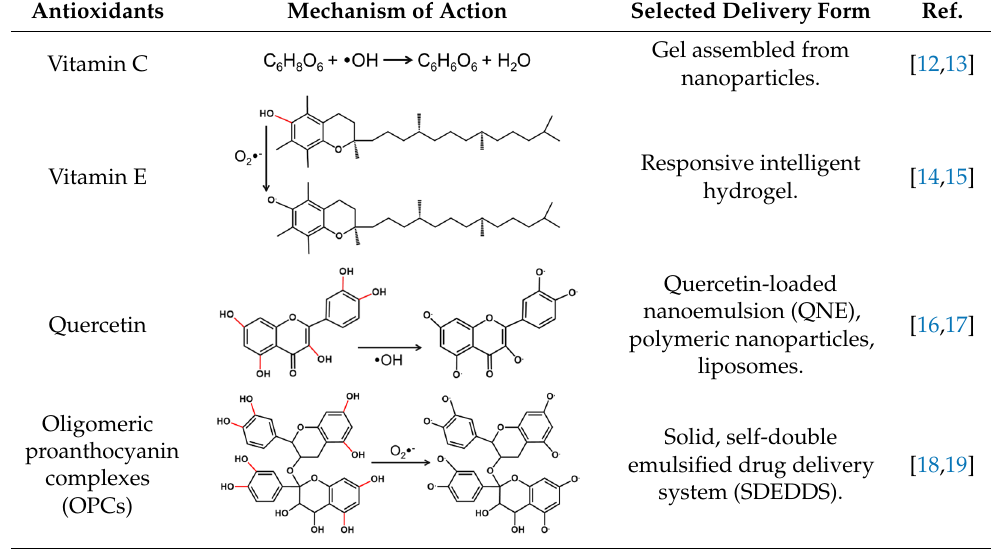
Table 1. Mechanism of action and delivery of some exogenous antioxidants.